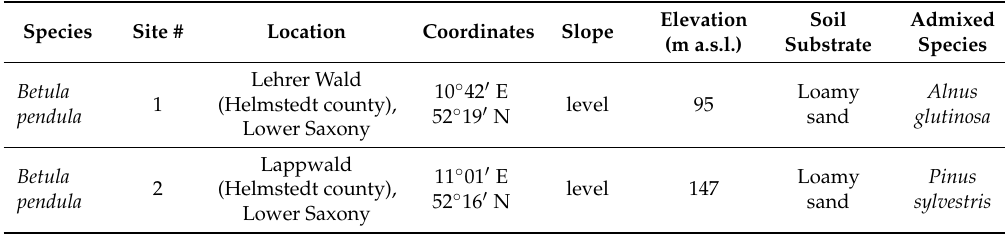
Table 2. Some physiographic characteristics of each of the two study sites per species in northern and central